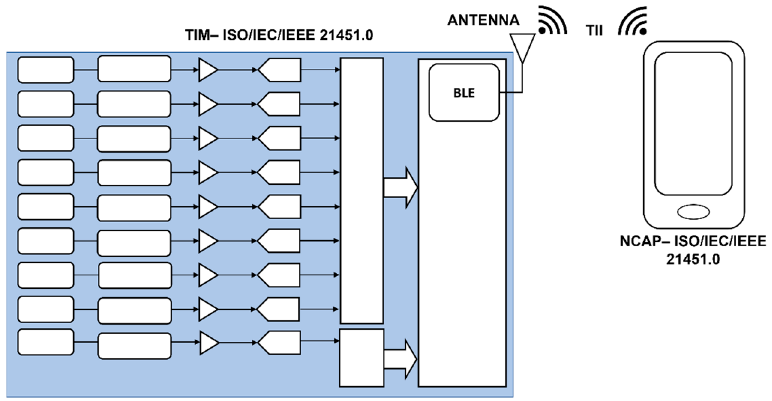
Figure 3. Network representation for the wearable sensing system of Figure 2. Block names have been omitted, in order to focus on the main Dot 0 blocks: TIM, TII and NCAP. Anyway, they are represented by using the same symbol of Figure 2.